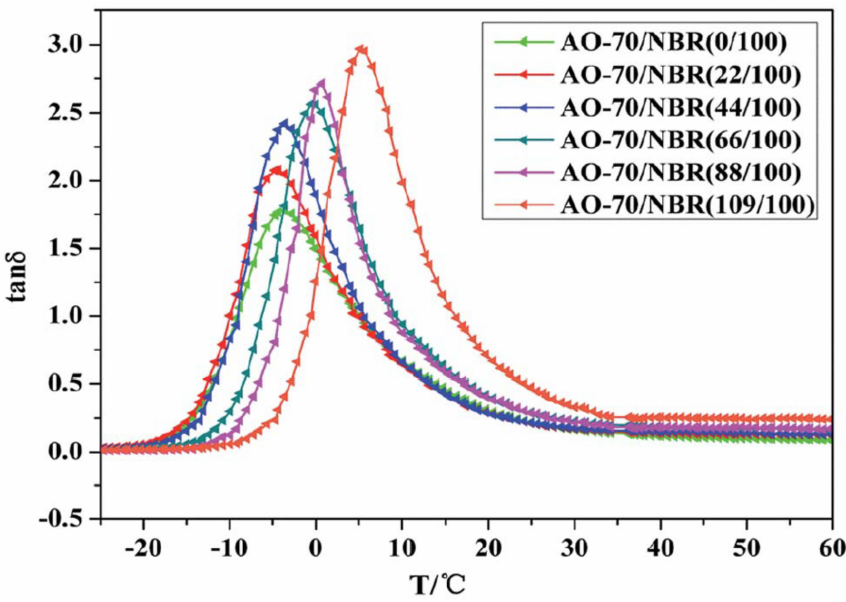
Figure 10. Temperature dependence of the damping loss factor (tan δ ) of NBR and AO-70/NBR composites